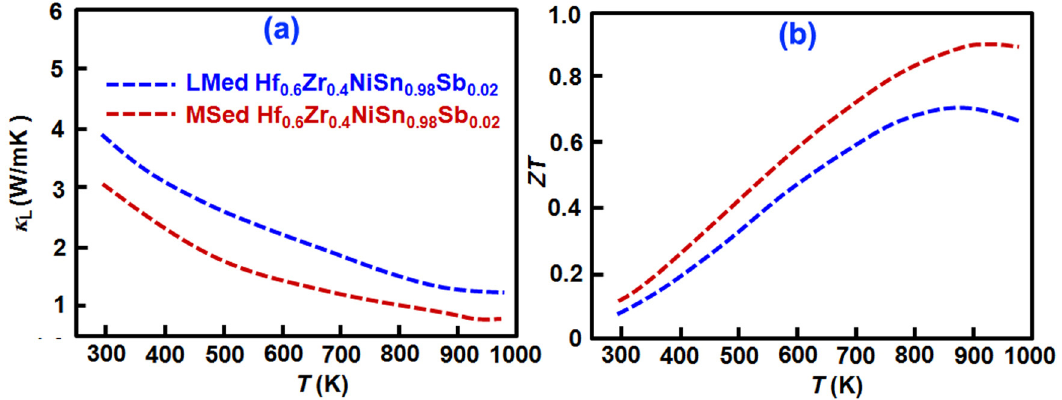
Figure 17. Temperature dependence of the thermal conductivity and ZT values of levitation melting (LM) and melt spinning (MS) prepared (Hf,Zr)NiSn based HH compounds. The data is adopted and calculated from Reference